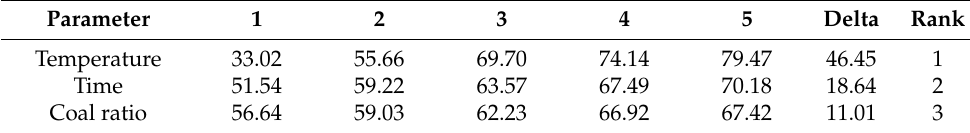
Table 5. Range analysis results of the orthogonal metallizing test.